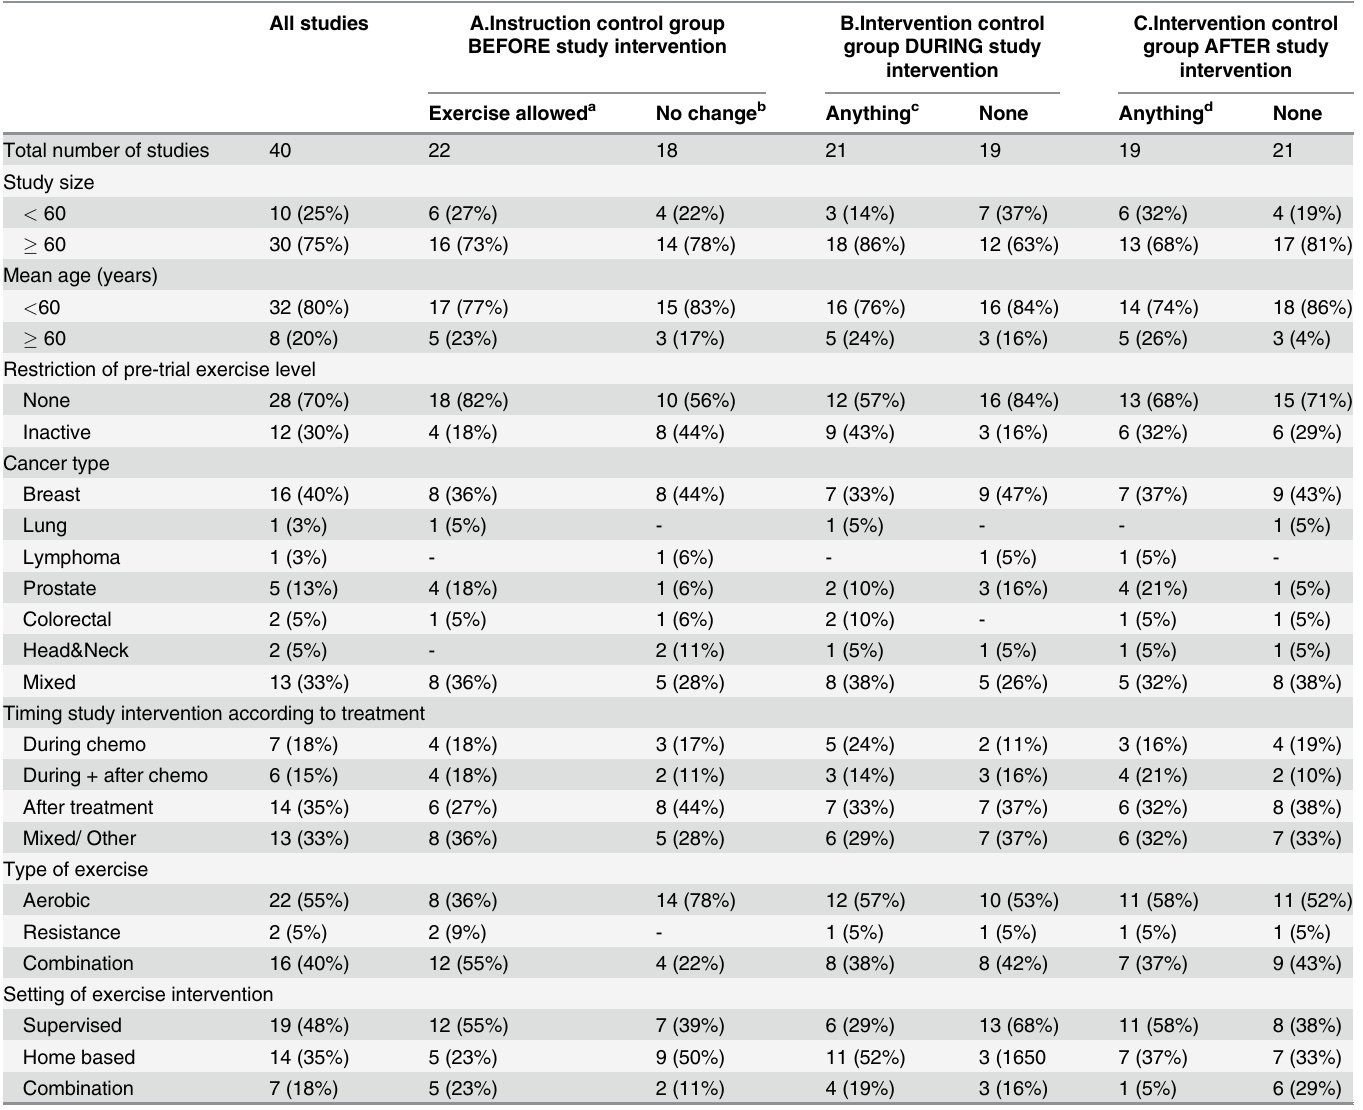
Table 1. Summary of characteristics of included